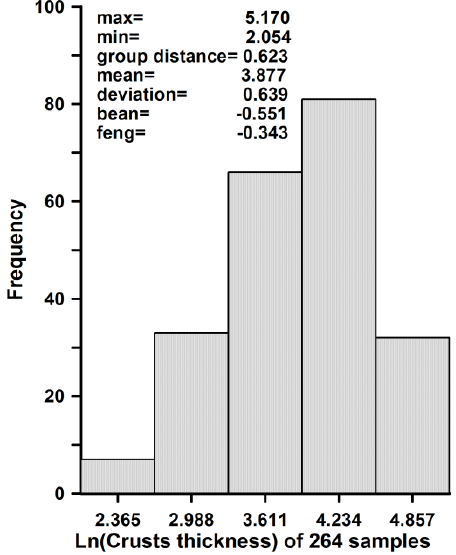
Figure 2. Logarithmic normal distribution histogram of the unified and transformed data.